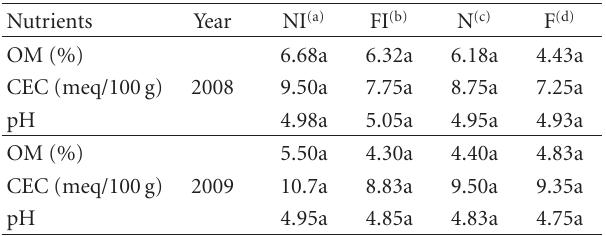
Table 3: Means separation for the values of soil organic matter (OM), cation exchange capacity (CEC), and